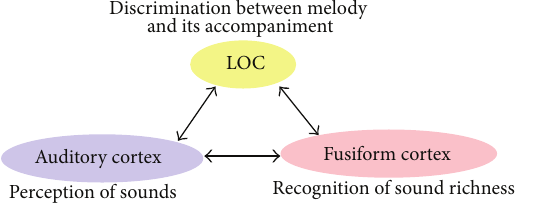
Figure 9: Diagram of cognitive processing during listening to music with